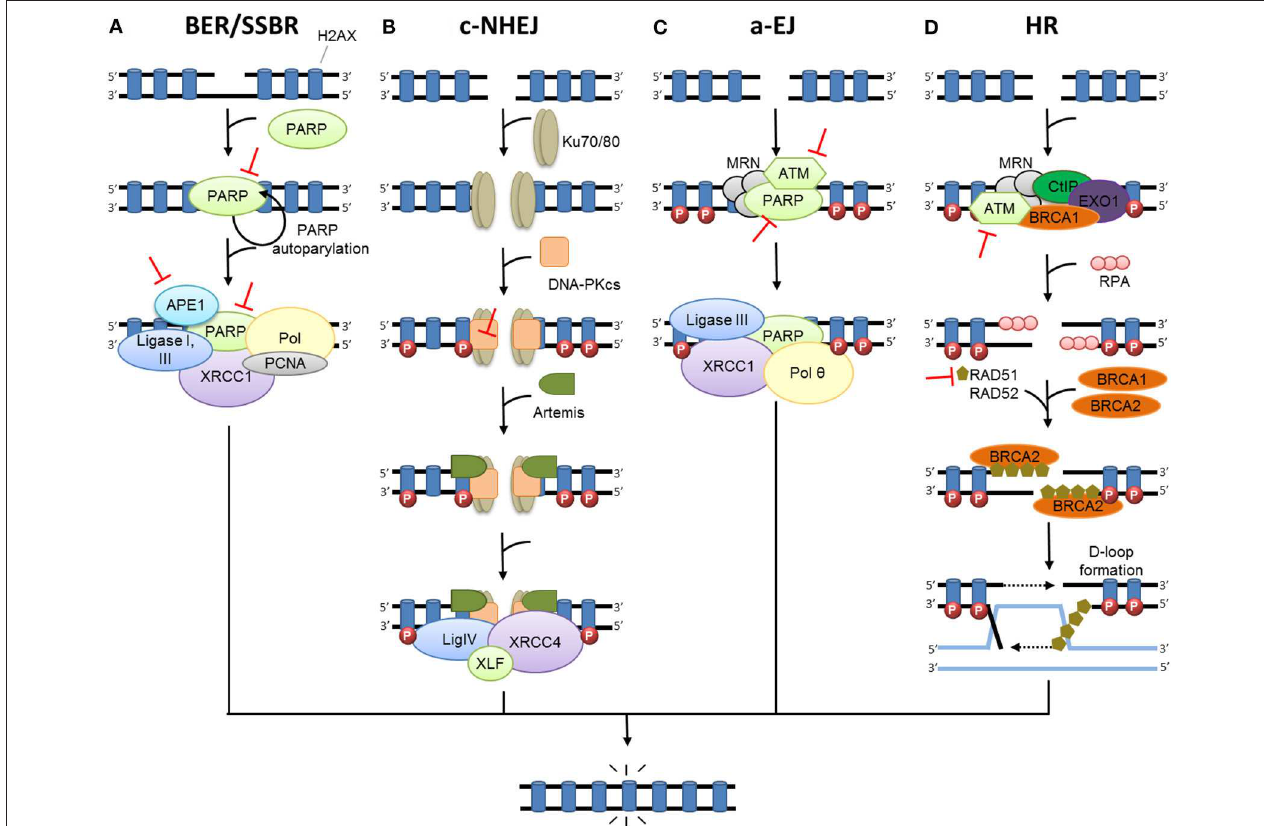
FIGURE 1 | DNA damage repair after radiation therapy. In irradiated cells, a number of DNA lesions are induced including single (SSB) and double-strand breaks (DSB). (A) SSBs are corrected by the part of base excision repair (BER) known as single-strand break repair (SSBR). The binding of PARP to SSB activates its auto-PARylation and leads to the recruitment of BER/SSBR proteins including AP endonucleases (APE1), XRCC1 (helper protein), PCNA, FEN, PNK, and DNA polymerases (Pol; damage processing) and DNA ligases. (B) In c-NHEJ, DSB is recognized by the Ku80-Ku70 heterodimer, which leads to DNA-dependent protein kinase catalytic subunit DNA-PKcs recruitment, gathering the DNA-PK complex and activating its kinase activity. This leads to the involvement of repair proteins (XRCC4, DNA ligase IV and others), which perform the processing and final junction reaction. (C) When c-NHEJ is impaired, an alternative pathway called a-EJ (alternative EJ) takes place and involves mainly PARP1, XRCC1, ligase III, MRN complex and the DNA polymerase θ . (D) In HR, after ATM activation, the DSB site is bounded by the MRE11-RAD50-NBS1 complex (MRN). The consequence is the phosphorylation of a set of targets including H2AX ( γ -H2AX), localized at the site of DSB. HR uses the sister chromatid as a model to repair DSB. First, the resection of the DNA at DSB results in a 3 ′ single-strand DNA, which is then coated by proteins of replication A (RPA). Subsequently, proteins of the RAD family are recruited and mediate the invasion of the homologous strand of the sister chromatid, leading to the formation of Holliday junctions. DNA polymerases can then synthetize across the missing regions. The Holliday junctions are finally resolved by cleavage and followed by ligation of adjacent